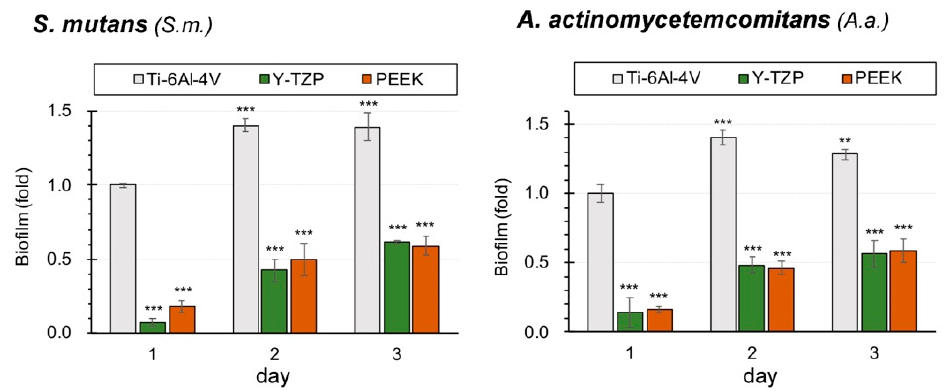
Figure 5. Biofilm formation ability of microbes (significant different to Ti-6Al-4V (day 1), ** p < 0.01, *** p < 0.001).